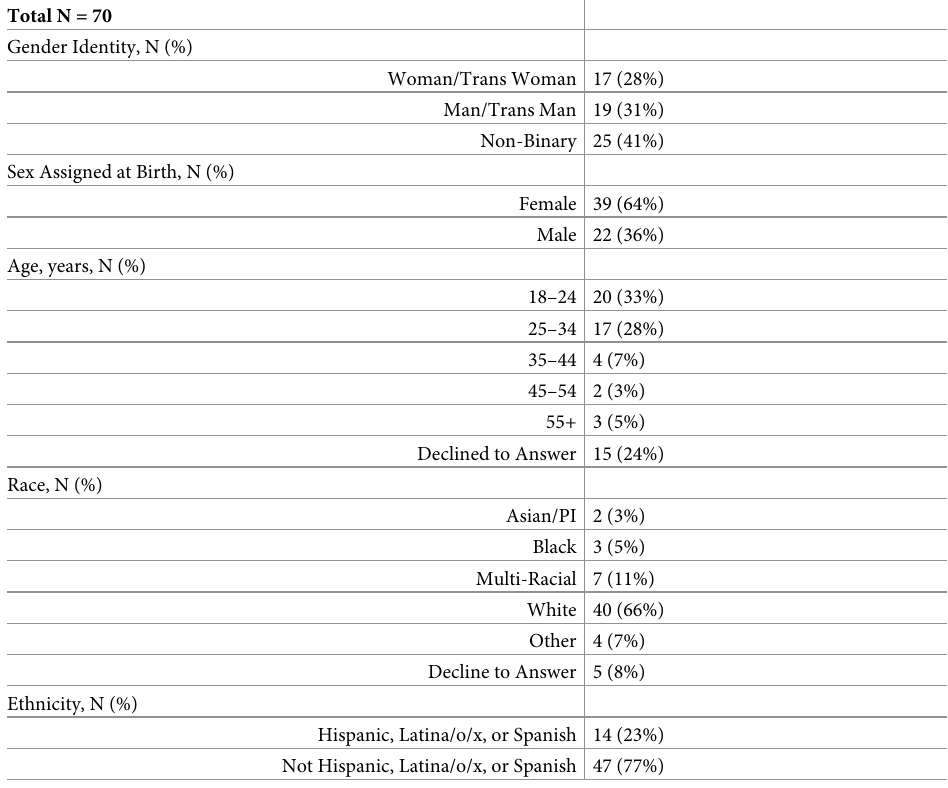
Table 1. Sociodemographic characteristics of community member focus group discussion participants (9 total focus